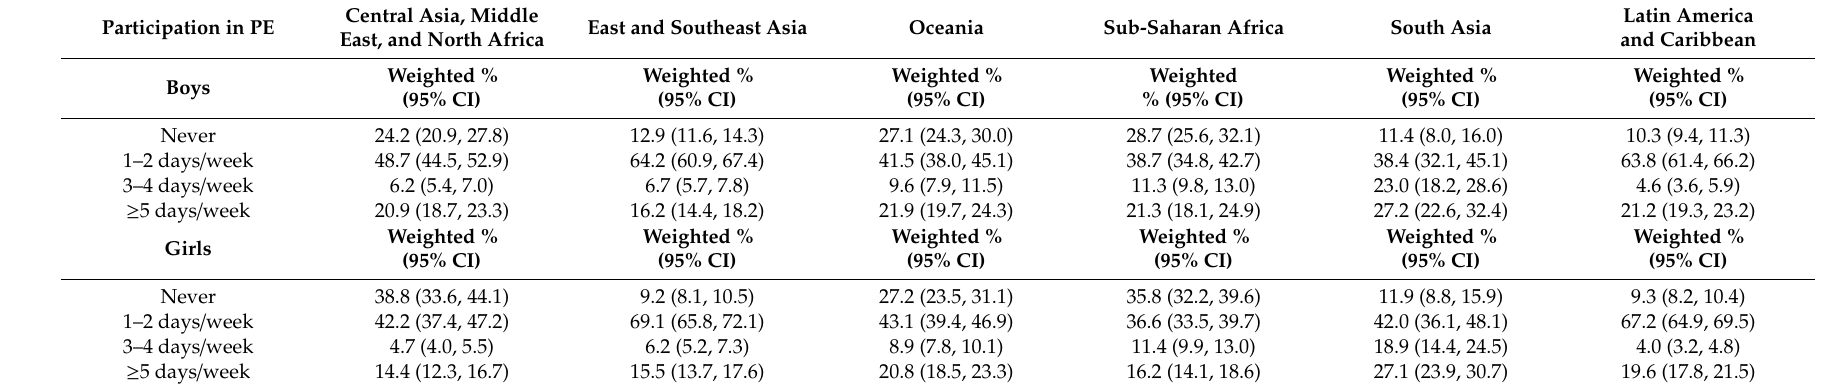
Table 4. Participation in physical education classes according to regions, stratified by